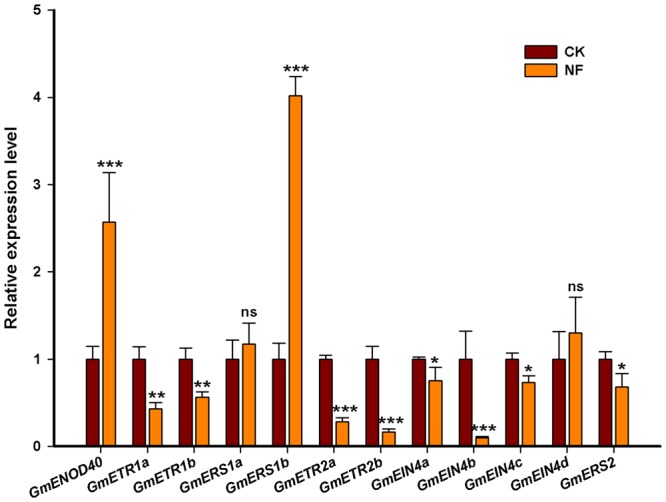
Expression analysis of the ethylene receptor genes in response to Nod factor (NF). The expression pattern of the ethylene receptor genes was analyzed by qRT-qPCR in response to NF (10-8 M) treatment, where GmENOD40 was chosen to be a positive control. The expression was normalized against the geometric mean of the reference gene GmELF1b. The experiments were done for three independent times. Error bars indicate SD. Statistically significant difference (Student’s t-test) are indicated as follows: ns, no significance P > 0.05; ∗P < 0.05; ∗∗P < 0.01; ∗∗∗P < 0.001.